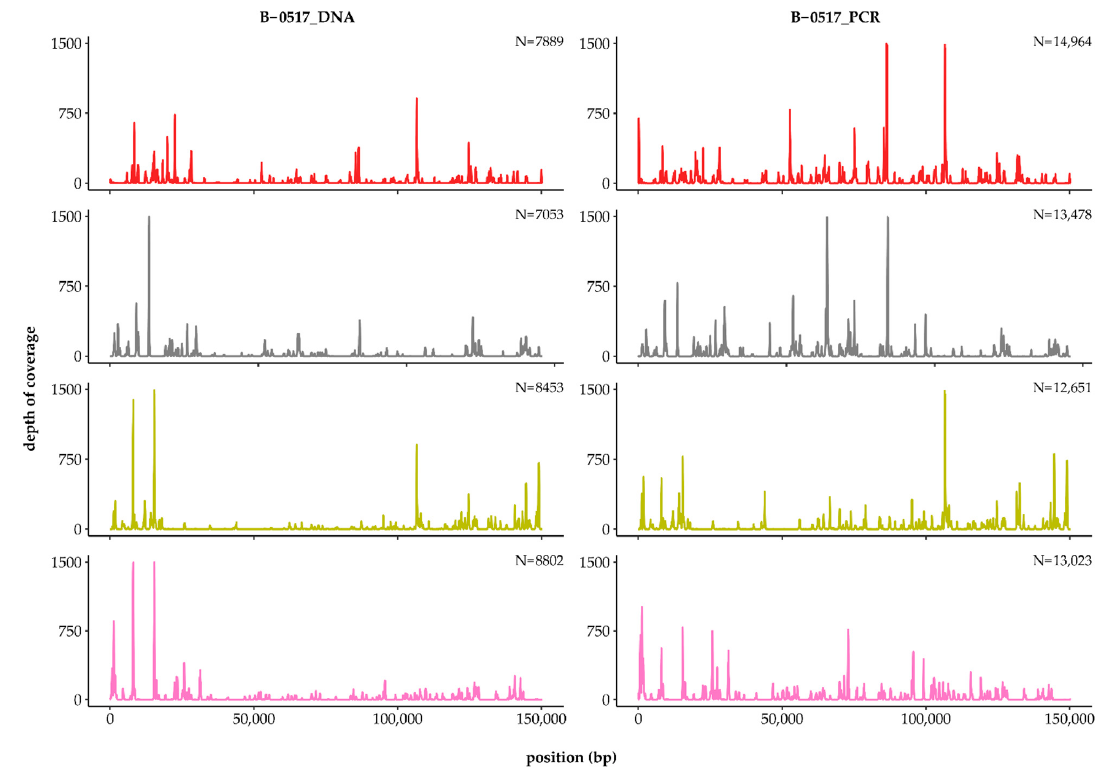
Figure 3. Reads covering potential recombination breakpoints. Reads that mapped perfectly to the GTPV strain or the LSDV vaccine strains were first removed from the B-0517_DNA and B-0517_PCR datasets. Potential recombination breakpoints were subsequently identified by mapping the re- maining reads against the genomes of LSDV/Russia/Saratov/2017 (red), KZ-Kostanay-2018 (grey), LSDV/Russia/Udmurtiya/2019 (lime) or 20L42/Quyet-Thang/VNM/20 (pink), allowing no mis- matches. The number of paired-end reads is indicated in the top right corner of each subplot.